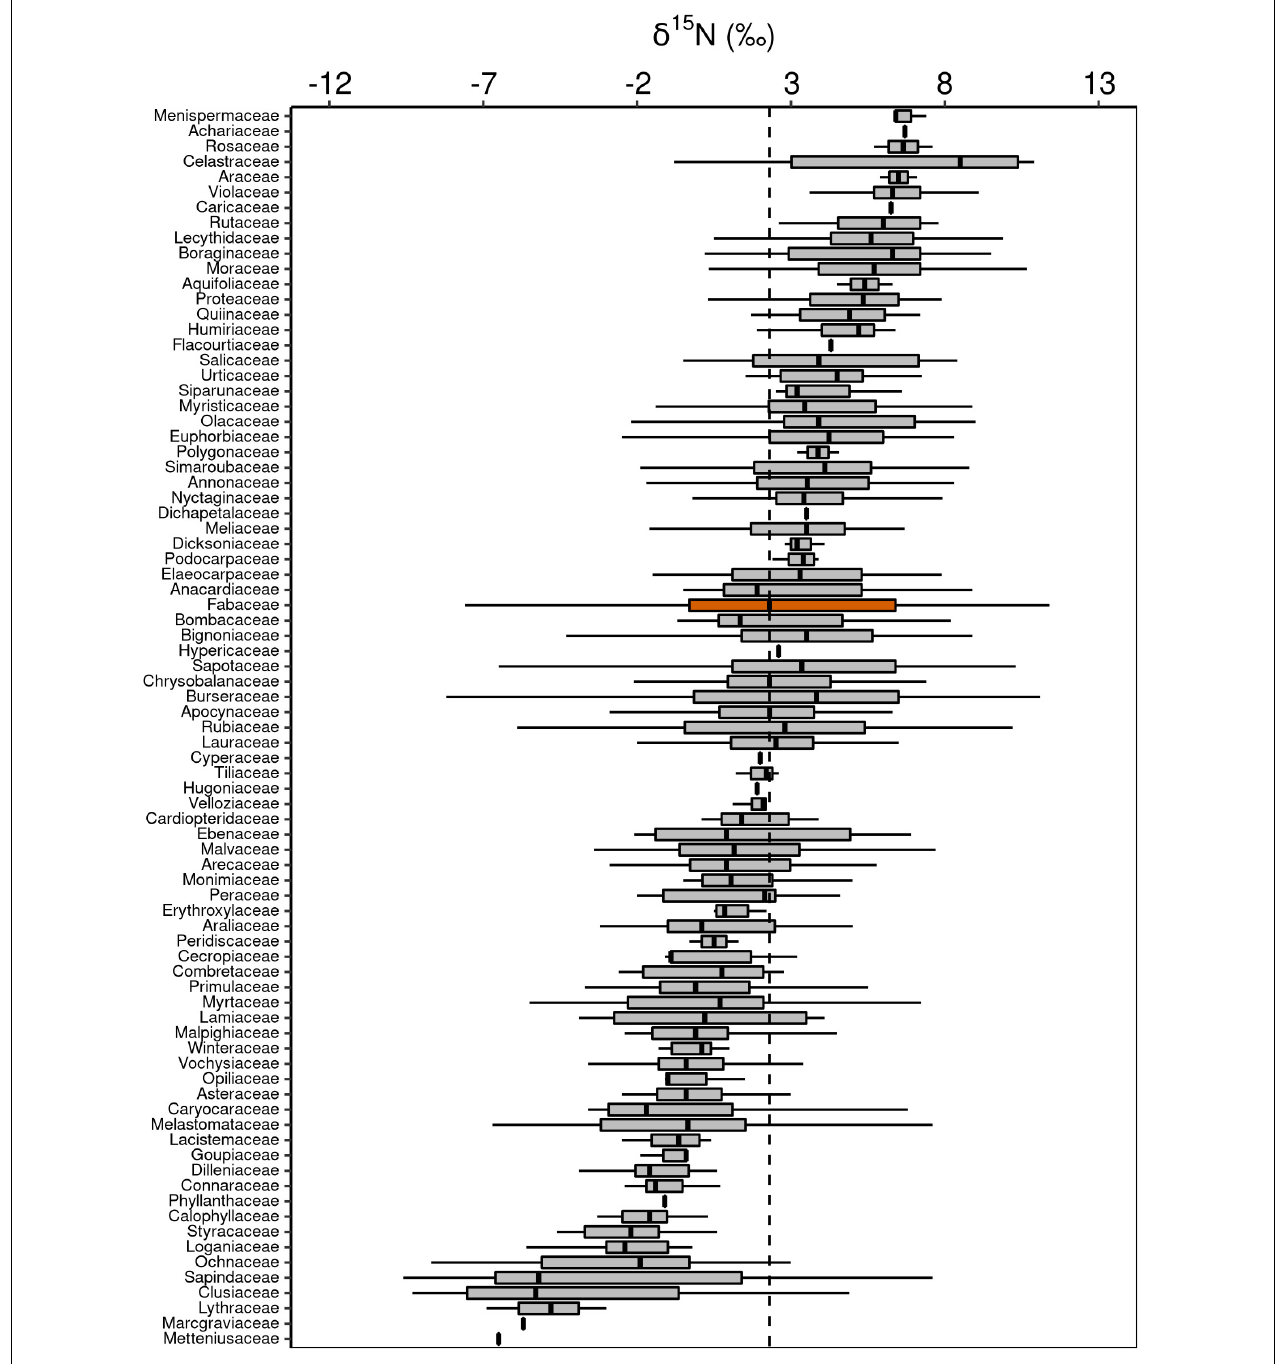
FIGURE 5 | Box-plots of foliar δ 15 N of botanical families in decreasing order. The vertical lines inside each box represent the median; the box represents the first and third quartiles; and the bars represent the interquartile range. The vertical dashed line represents the mean of the entire population. The orange box is evidencing